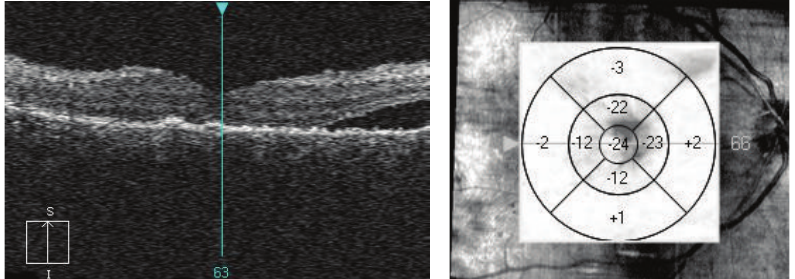
Figure 4: OCT scan a month after SDM treatment. Resorption of the subretinal fluid and slight reduction of the retinal thickening in comparison to the scan taken before laser